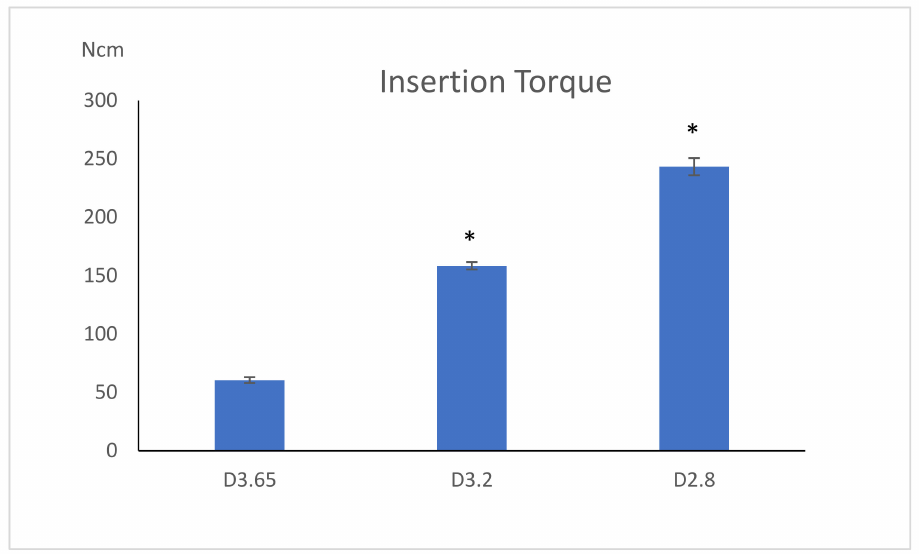
Figure 7. Insertion torque values in Ncm measured in the di ff erent study groups and expressed as averages and standard errors. * denotes p < 0.001.